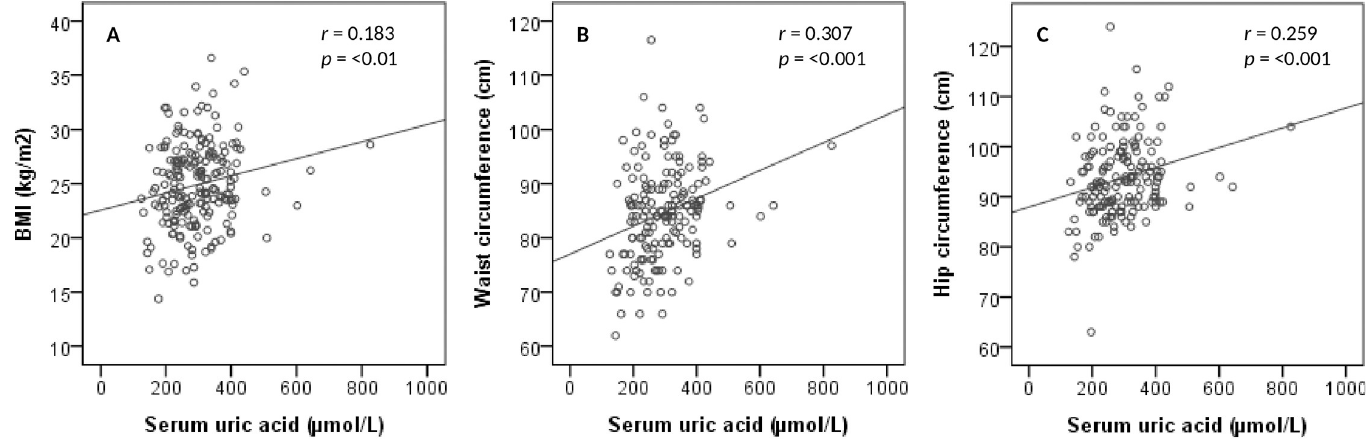
PLOS ONE | https://doi.org/10.1371/journal.pone.0206850 November1,